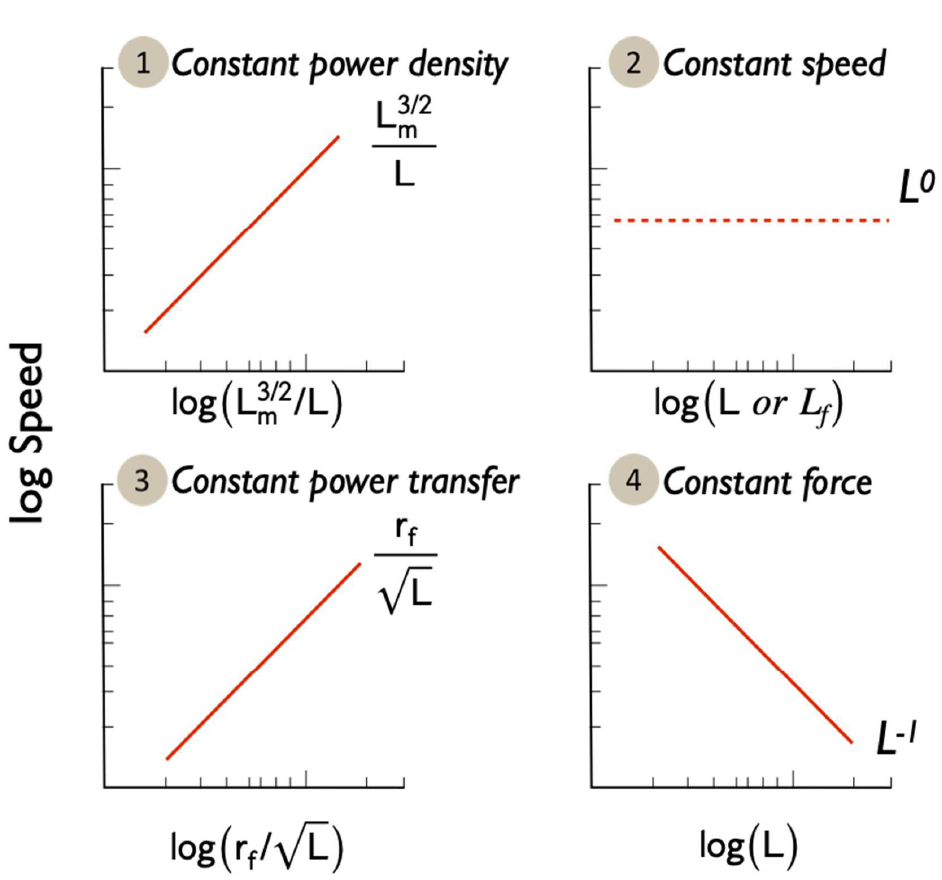
Figure 2. Predicted relationships between swimming speed and morphology for the four hypotheses. Note the Log-Log axes.